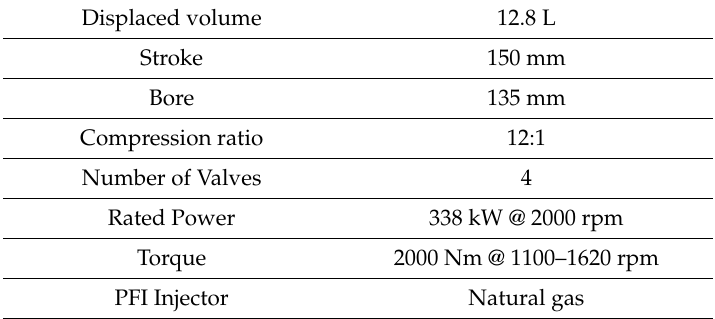
Table 2. CNG fuel mixture used during experimental tests.